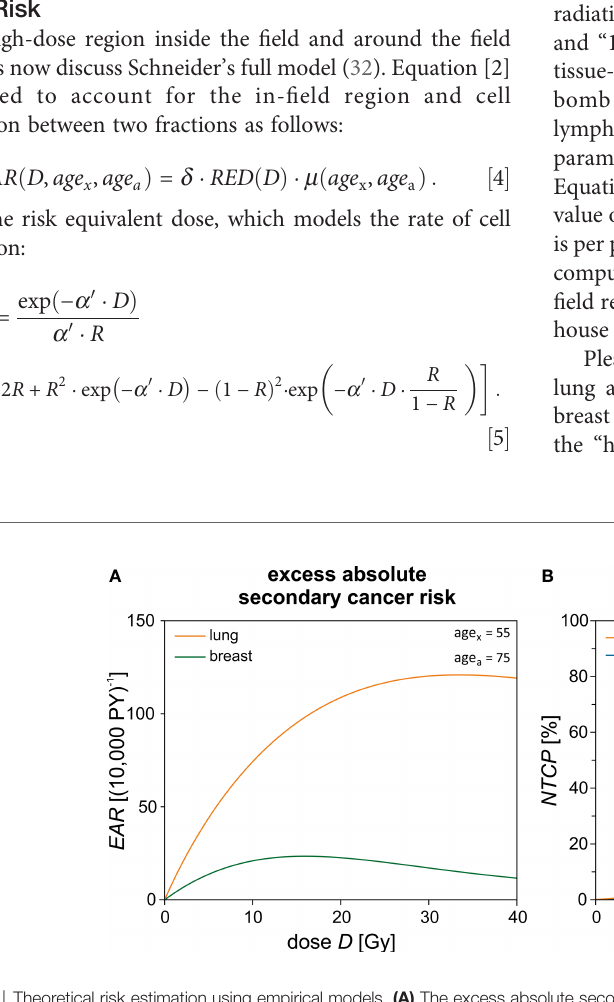
FIGURE 4 | Theoretical risk estimation using empirical models. (A) The excess absolute secondary cancer risk ( EAR ) is calculated for the lung and the breast dependent on the dose D using Schneider ’ s model. The difference between the age exposed ( age x ) and the attained age ( age a ) is 20 years. (B) Normal tissue complication probability ( NTCP ) calculation for the lung and its respective endpoints dependent on the equivalent uniform dose ( EUD ).